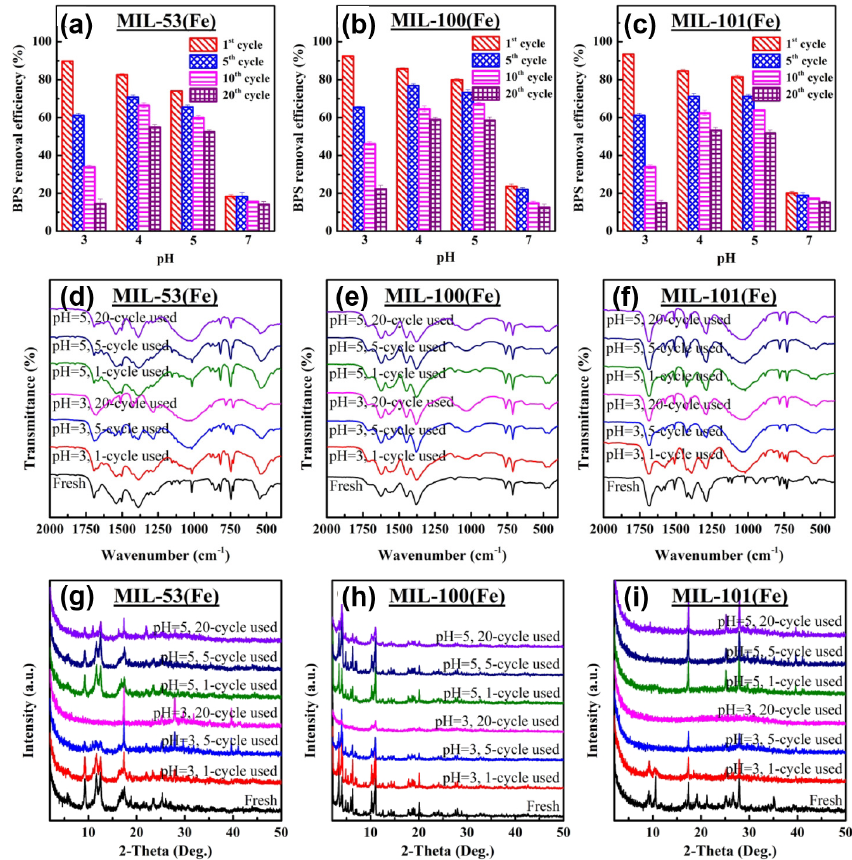
Figure 3. BPS removal efficiency in ( a ) MIL − 53(Fe), ( b ) MIL − 100(Fe), and ( c ) MIL − 101(Fe) catalyzed Fenton-like processes at various pH levels; FTIR spectra of fresh and used ( d ) MIL − 53(Fe), ( e ) MIL − 100(Fe), and ( f ) MIL − 100(Fe); XRD spectra of fresh and used ( g ) MIL − 53(Fe), ( h ) MIL − 100(Fe), and ( i ) MIL − 101(Fe) [31].